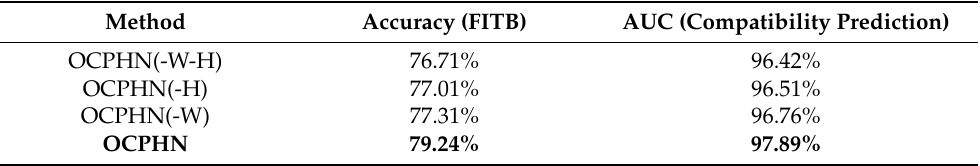
Table 3. The performance of our proposed method with different component